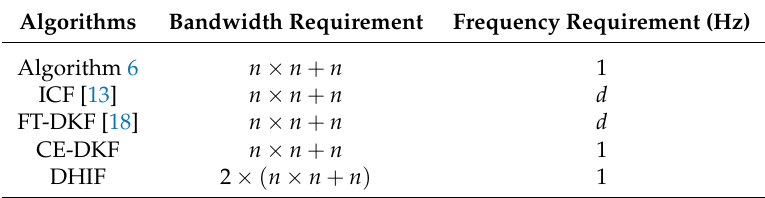
Table 3. Communication requirements of different algorithms. FT-DKF: finite-time distributed Kalman filter; ICF: information consensus